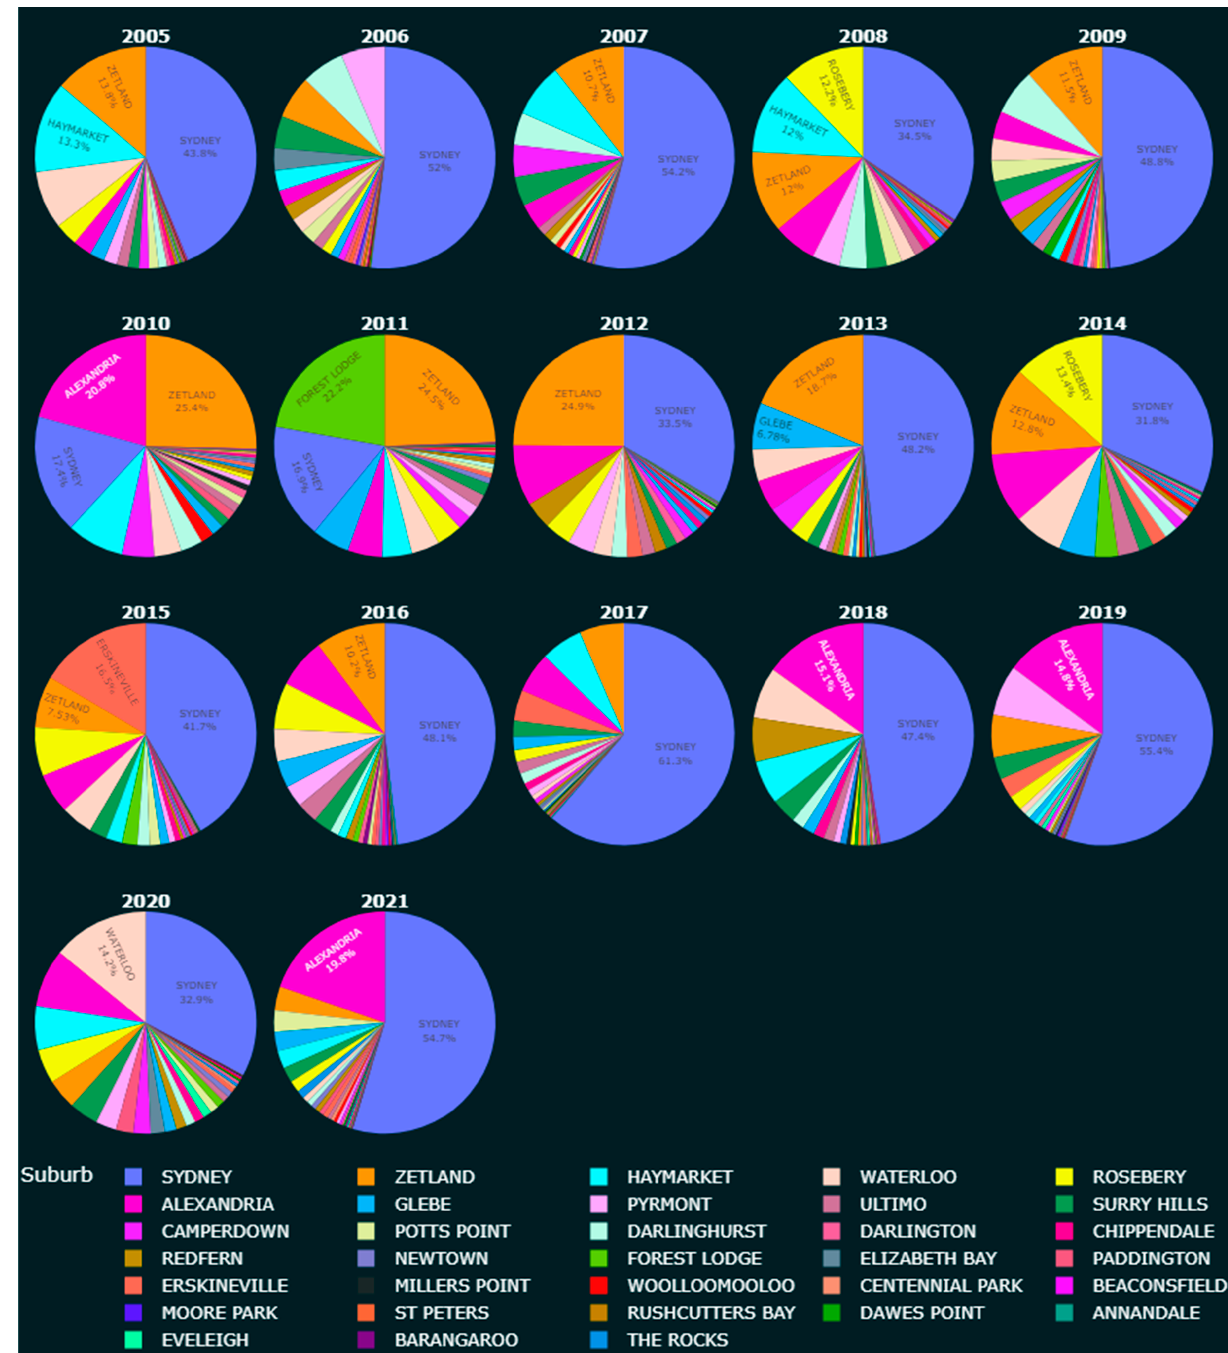
Figure 29. Total estimated cost by suburb by year (2005–2021).